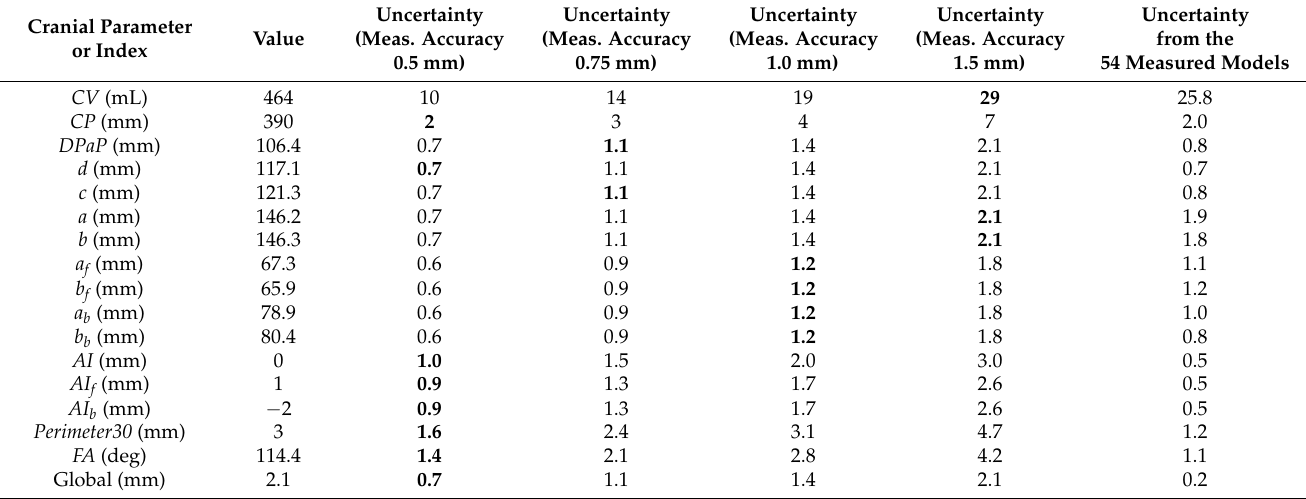
Table 3. Cranial anthropometric parameters along with their corresponding uncertainties for different values of measurement accuracy (0.5, 0.75, 1, and 1.5 mm). Experimental uncertainties derived from the 54 measured models are provided in the last column. The bold values highlight the closest largest uncertainties.